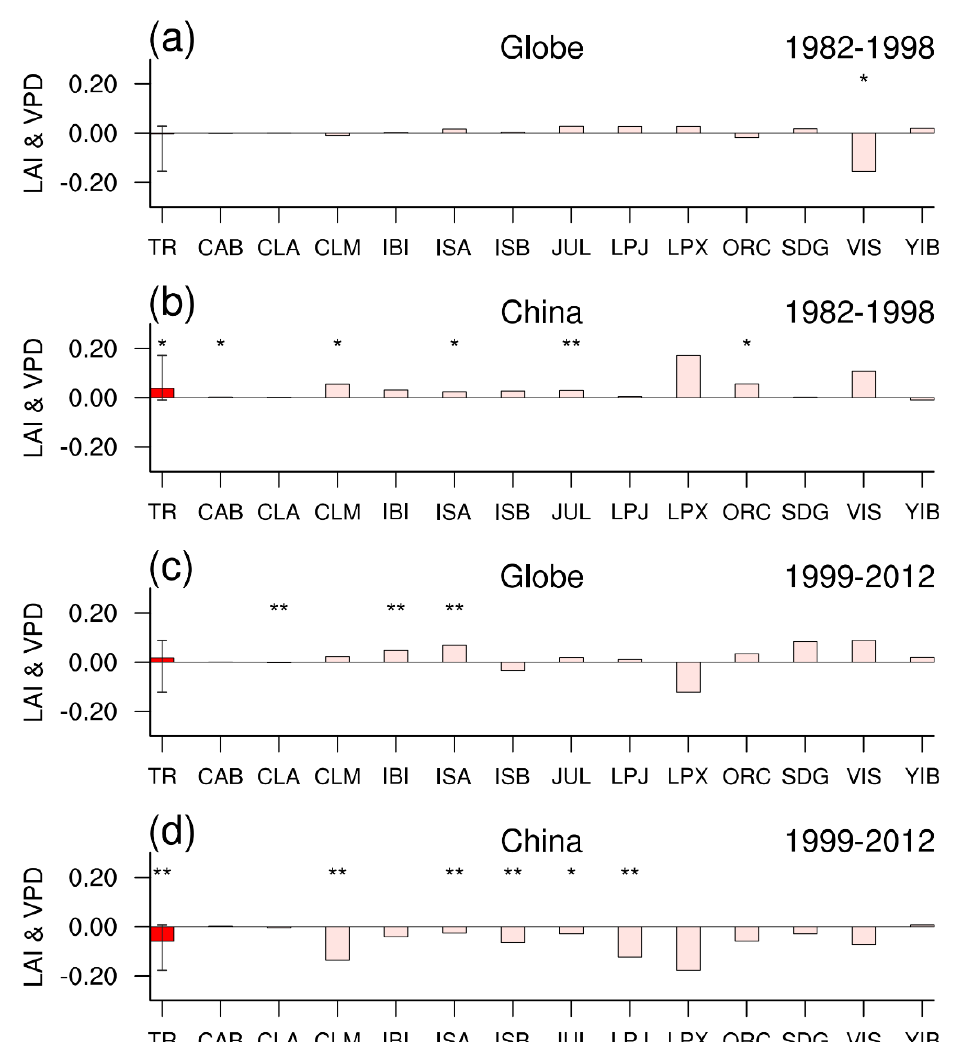
Figure 6. Sensitivities of LAI to VPD during the growing season for ( a , c ) the globe and ( b , d ) China during ( a , b ) 1982 – 1998 and ( c , d ) 1999 – 2012, derived from 13 TRENDY models (unit: (hPa) −1 ). TR means the average of TRENDY models. Horizontal lines indicate ± σ . Two asterisks indicate that the trend is statistically significant ( p < 0.05) and one asterisk indicates statistical significance at the 0.1 level.